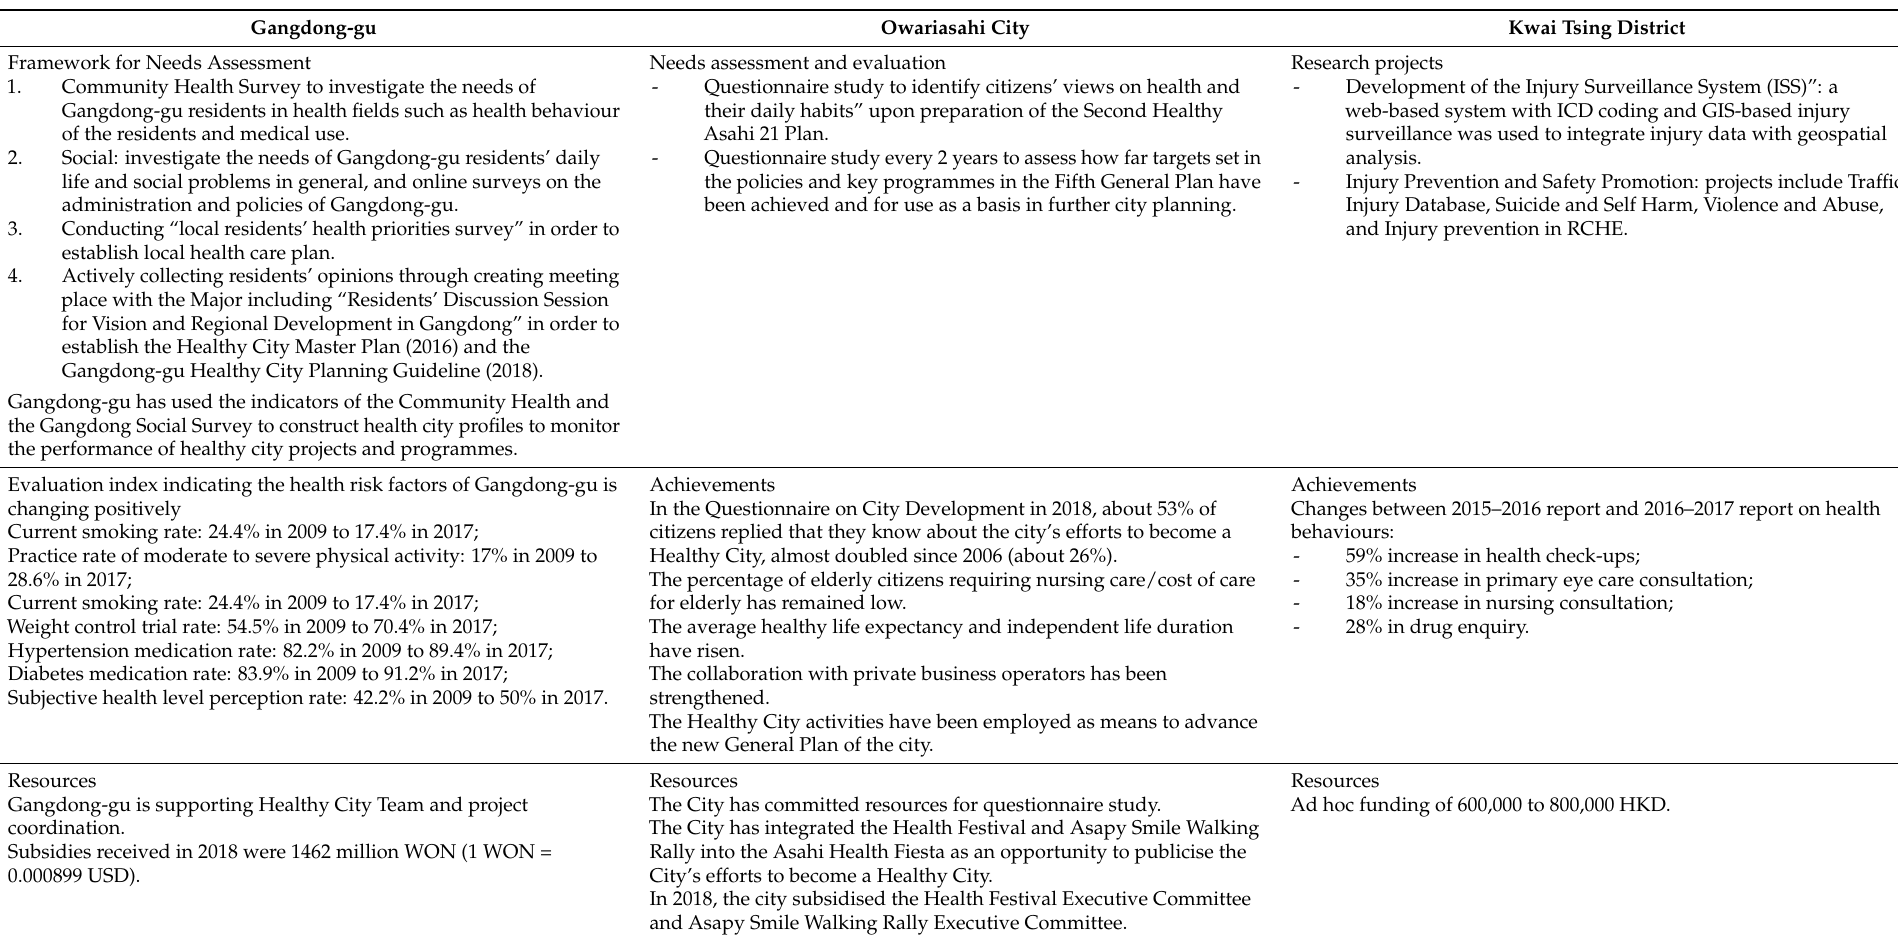
Table 5. Research and